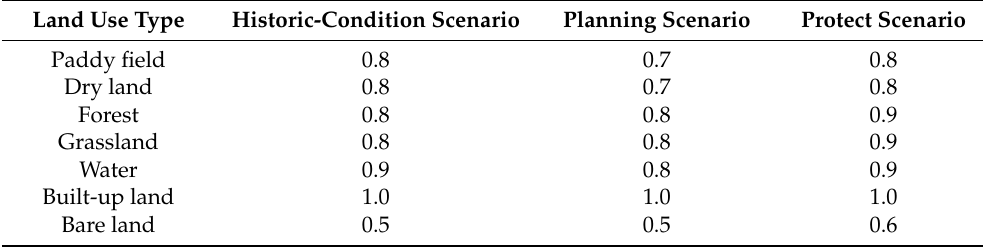
Table 3. The resistance factors for each land use type under different